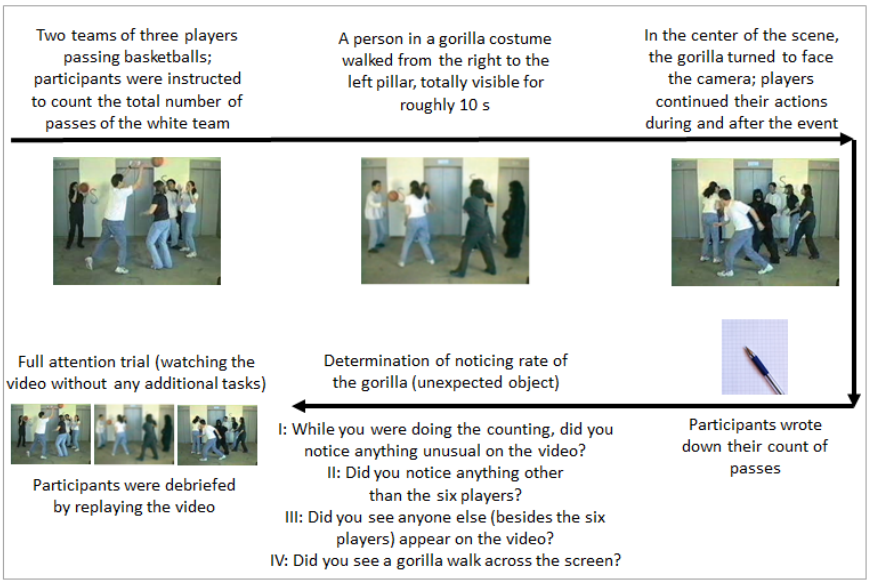
Figure 1. A flow chart demonstrating the procedure of Experiments 1 and 2.